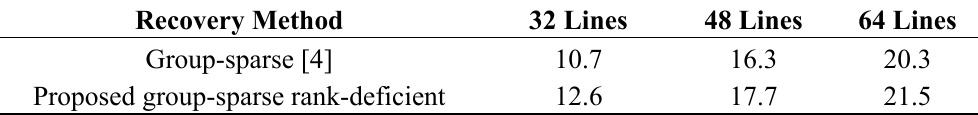
Table 4. In vivo : SNR for different Fourier mapping with different